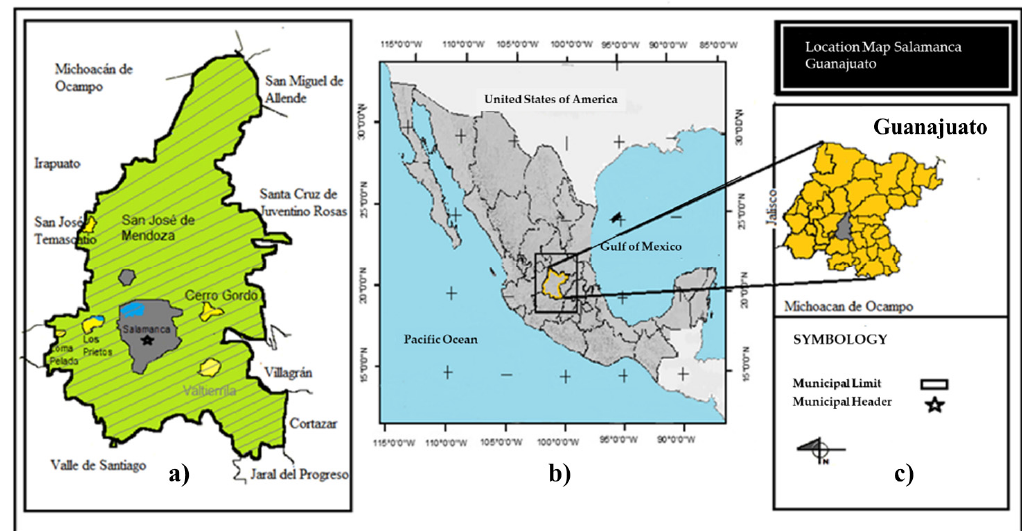
Figure 2. ( a ) High soil and water pollution of the Salamanca entity, ( b ), Guanajuato location in the Mexican Republic Map ( c ) Salamanca, the most Polluted entity area in Guanajuato. Source: Adapted from Google Earth (2020) [32].